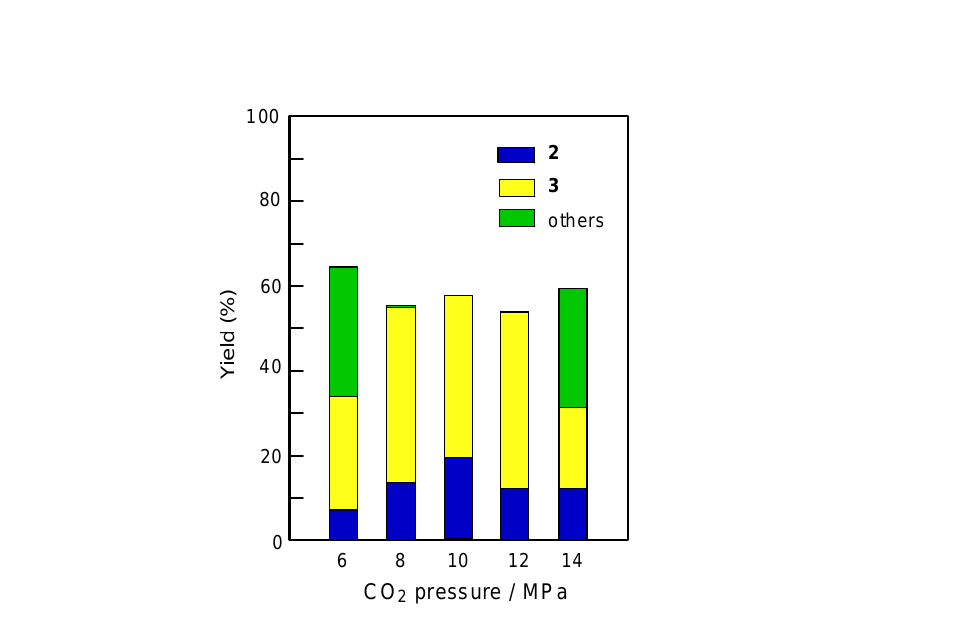
pressure on the reaction of CO and 2-aminoethanol. Reaction conditions: 2 2 CO , 0.7 mmol; temperature, 150 2 3 °C; time, 6